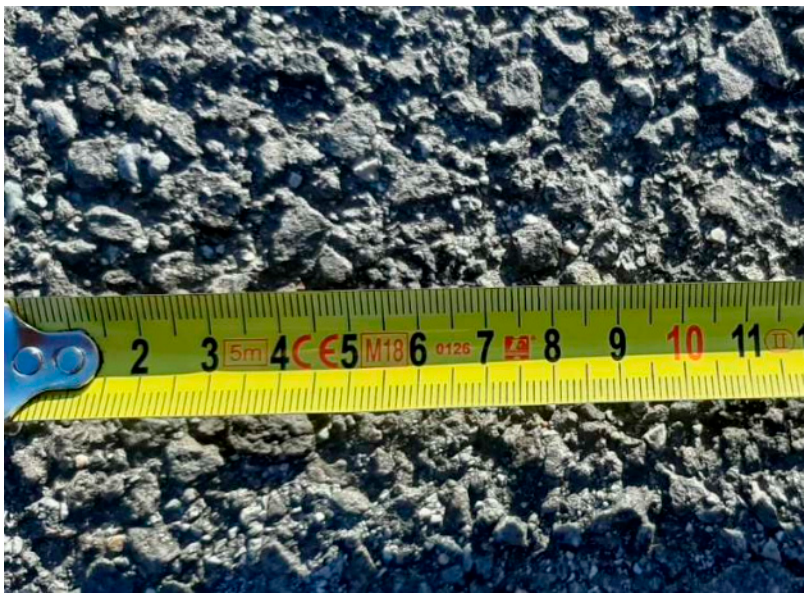
Figure 3. Surface selected for measuring the braking characteristics. Prior to measurements, a 5 km long route with particular brake components was driven each time, during which braking was performed continuously. There were 8 measurements performed with the low-priced, mid-priced and high-priced brake components at an initial driving speed of approximately 50 km.h − 1 . Then, the results were averaged. The driver accelerated the vehicle to the speed of 50 km.h − 1 , and when the front part of the vehicle reached the beginning of the braking section signposted by a traffic cone, the accelerator pedal was released as fast as possible and the brake pedal was applied. The same effort to control the steering affecting the brake pedal was controlled by a Corsys pedometer during all the measurements (Figure 4).